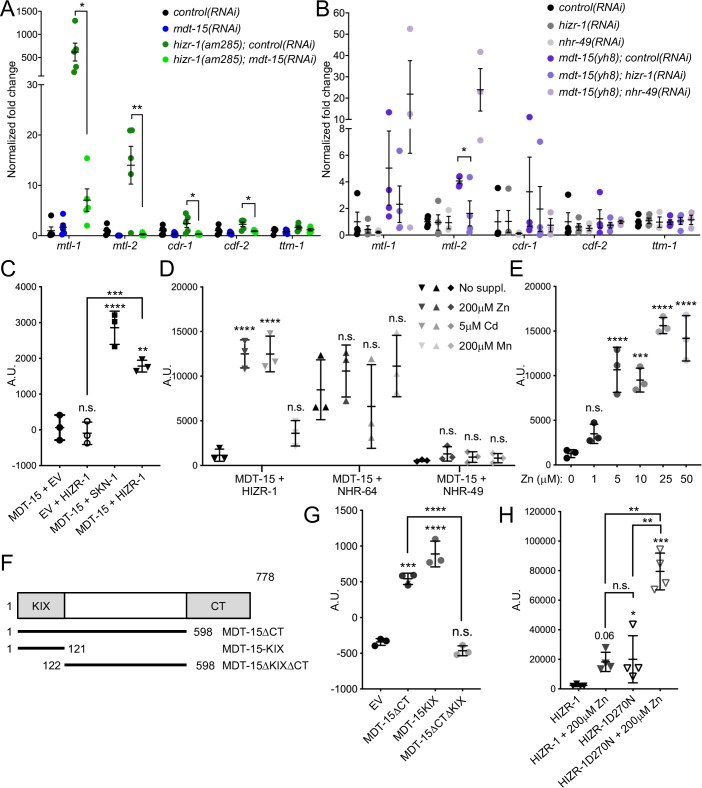
MDT-15 and HIZR-1 are co-dependent for metal responsive gene induction and physically bind in cadmium and zinc-enhanced fashion.[A-B] qRT-PCR analysis of zinc and cadmium-responsive genes. The graphs show fold-inductions of mRNAs normalized to the average of wild-type control(RNAi) worms. Error bars: SEM. Statistical analysis: * p < 0.05, ** p < 0.01, unpaired Student’s t-test for indicated comparisons. [A] Comparison of wild-type and hizr-1(am285) gf worms grown on control or mdt-15 RNAi (n = 5 independent repeats). [B] Comparison of wild-type and mdt-15(yh8) gf worms grown on control, hizr-1, or nhr-49 RNAi (n = 3–4 independent repeats). [C-E] Protein-protein interaction analysis using the Y2H system. Graphs show average interaction strength (arbitrary units, A.U.). Error bars: standard deviation. [C] Interaction between MDT-15 and HIZR-1, with Empty Vector (EV)–HIZR-1 and MDT-15–EV as negative controls, and MDT-15–SKN-1c as a positive control (n = 3 independent repeats). Statistical analysis: n.s. = not significant; ** p < 0.01, *** p < 0.001, **** p < 0.0001, One-way ANOVA, multiple comparisons, Tukey correction. All comparisons for “MDT-15 + EV” unless indicated by lines. Expression of HIZR-1 prey fusion proteins is shown in panel A of S1 Fig. [D] Average interaction strength between MDT-15 and HIZR-1; MDT-15 and NHR-64; and MDT-15 and NHR-49, all with no treatment, or treated with 200μM zinc, 5μM cadmium, or 200μM manganese (n = 3 independent repeats). Statistical analysis: n.s. = not significant; **** p < 0.0001, One-way ANOVA, multiple comparisons, Sidak correction; all comparisons to the pertinent “no supplement” control. Expression of HIZR-1, NHR-64, and NHR-49 prey fusion proteins is shown in panel B of S1 Fig. [E] Interaction between MDT-15 bait and HIZR-1 prey without zinc supplementation and with 1, 5, 10, 25, or 50μM supplementary zinc (n = 3 independent repeats). Statistical analysis: n.s. = not significant; *** p < 0.001, **** p < 0.0001, One-way ANOVA, multiple comparisons, Dunnett correction; all comparisons to “0μM zinc”. Expression of HIZR-1 prey fusion proteins is shown in panel C of S1 Fig. [F] The diagram shows the MDT-15 deletions analyzed for HIZR-1 binding in [G]. Numbers indicate amino acids; the N-terminal, NHR-binding KIX-domain (“KIX”) and the C-terminal autoactivation domain (“CT”) are shaded gray. [G-H] Protein-protein interaction analysis using the Y2H system. Graphs show average interaction strength (arbitrary units, A.U.). Error bars: standard deviation. [G] Interaction between empty vector (EV) or MDT-15 mutant (MDT-15ΔCT, MDT-15-KIX, or MDT-15ΔKIXΔCT) baits and a full-length WT HIZR-1 prey (n = 3 independent repeats). Statistical analysis: n.s. = not significant, **** p < 0.0001, One-way ANOVA, multiple comparisons, Sidak correction; comparisons are to “MDT-15ΔCT” unless indicated by lines. Expression of HIZR-1 prey fusion proteins is shown in panel D of S1 Fig. [H] Interaction between HIZR-1 and MDT-15 or HIZR-1-D270N and MDT-15 with and without zinc treatment (n = 4 independent repeats). Statistical analysis: n.s. = not significant, ** p < 0.01, *** p < 0.001, One-way ANOVA, multiple comparisons, Sidak correction; comparisons to “HIZR-1” unless indicated by lines. Expression of HIZR-1 prey fusion proteins is shown in panel E of S1 Fig.